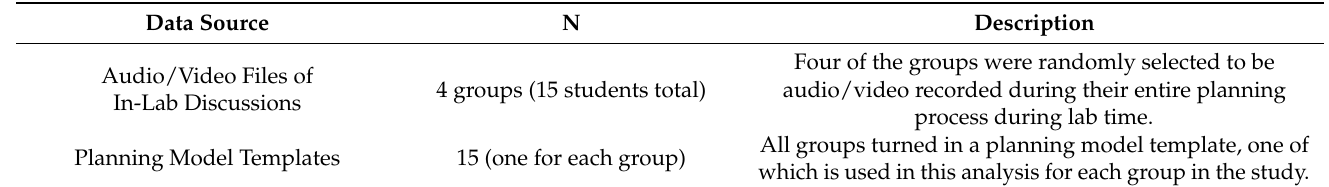
Table 1. Data overview for the current